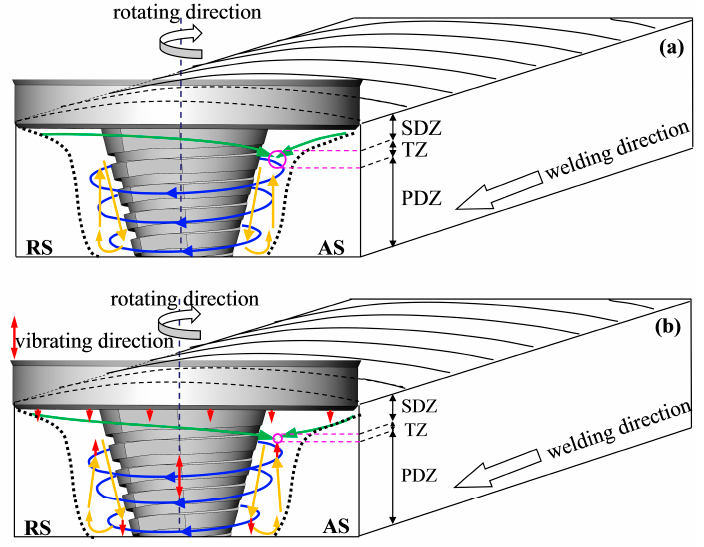
Figure 15. Physical models of the plastic material flow of the SZ in the joints: ( a ) FSW and ( b ) UAFSW.